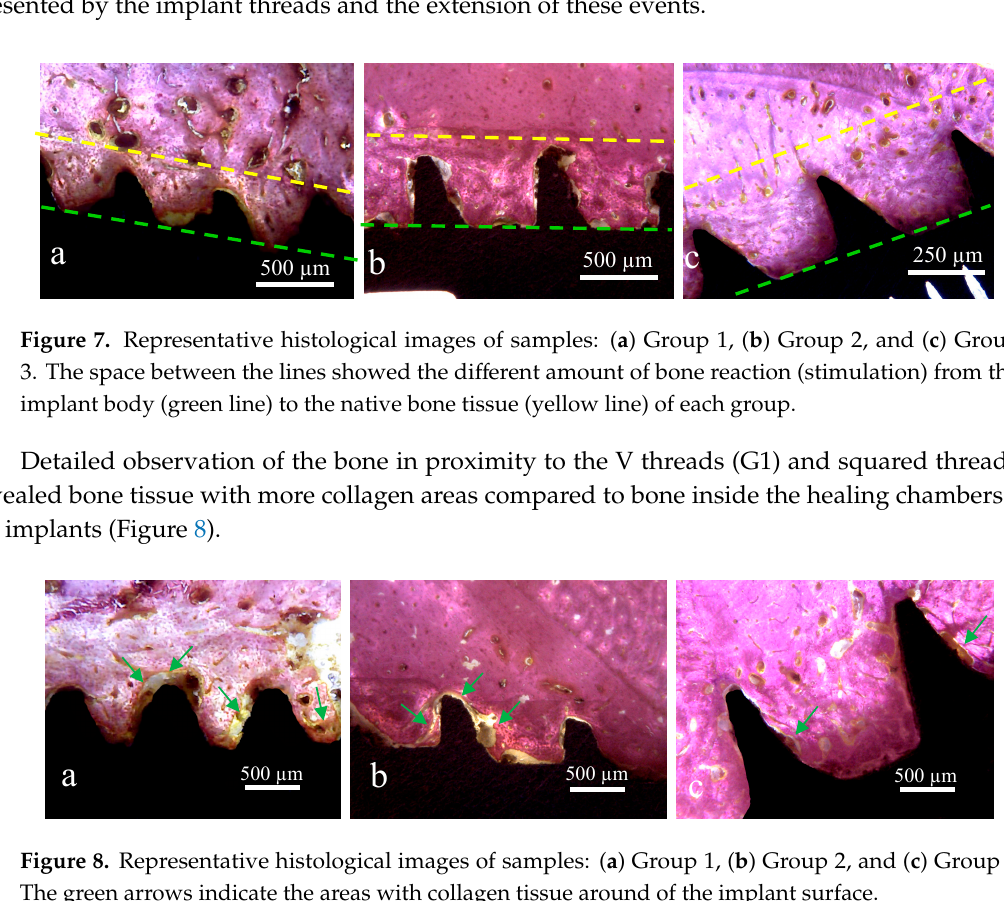
Figure 8. Representative histological images of samples: ( a ) Group 1, ( b ) Group 2, and ( c ) Group 3. The green arrows indicate the areas with collagen tissue around of the implant